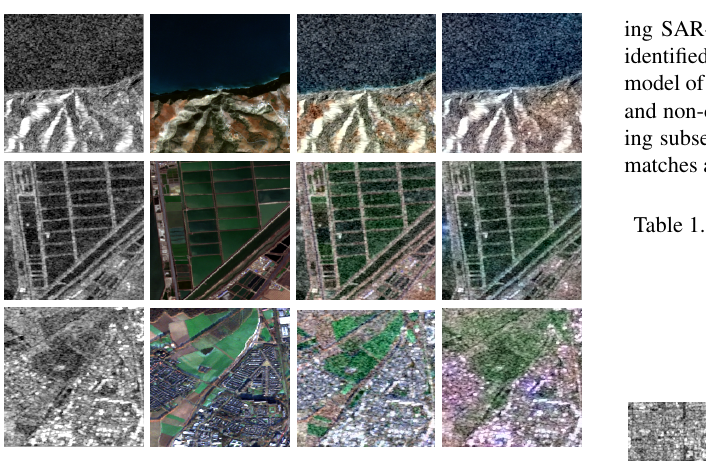
Figure 5. Some results for colorized SAR image patches. In each row, from left to right: original Sentinel-1 SAR image patch, corresponding Sentinel-2 RGB image patch, artificial color SAR patch based on color-space-based SAR-optical image fusion, artificial color SAR image predicted by a deep generative model.